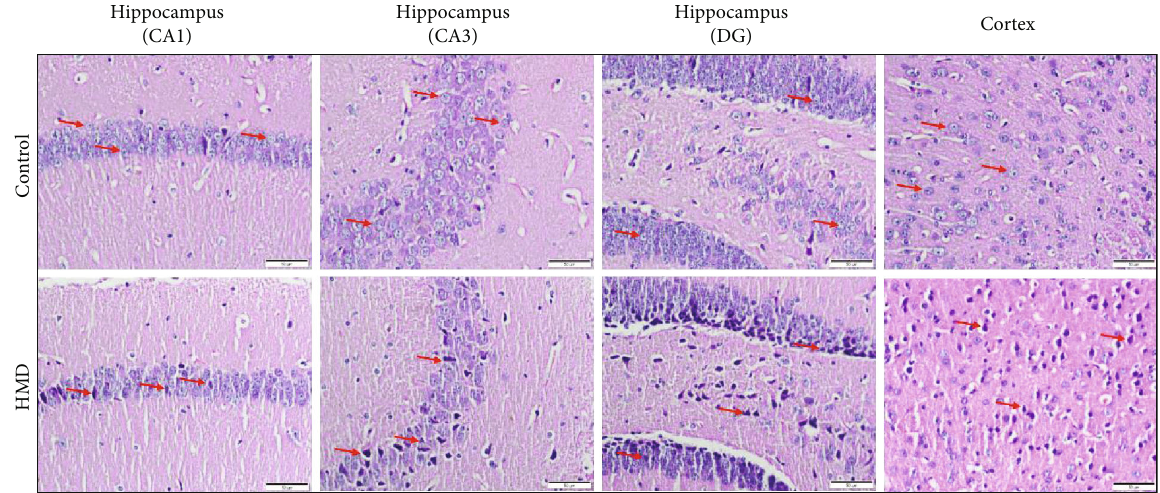
Figure 4: Images of HE staining. E ff ect of HMD on neuronal damage in the hippocampus and cortex. Sections of the hippocampus CA1, CA3, DG region, and cortex were obtained and stained with HE (magni fi cation, 400x). (a) Showed representative hippocampal cytoarchitecture of CA1, CA3, DG, and cortex in each